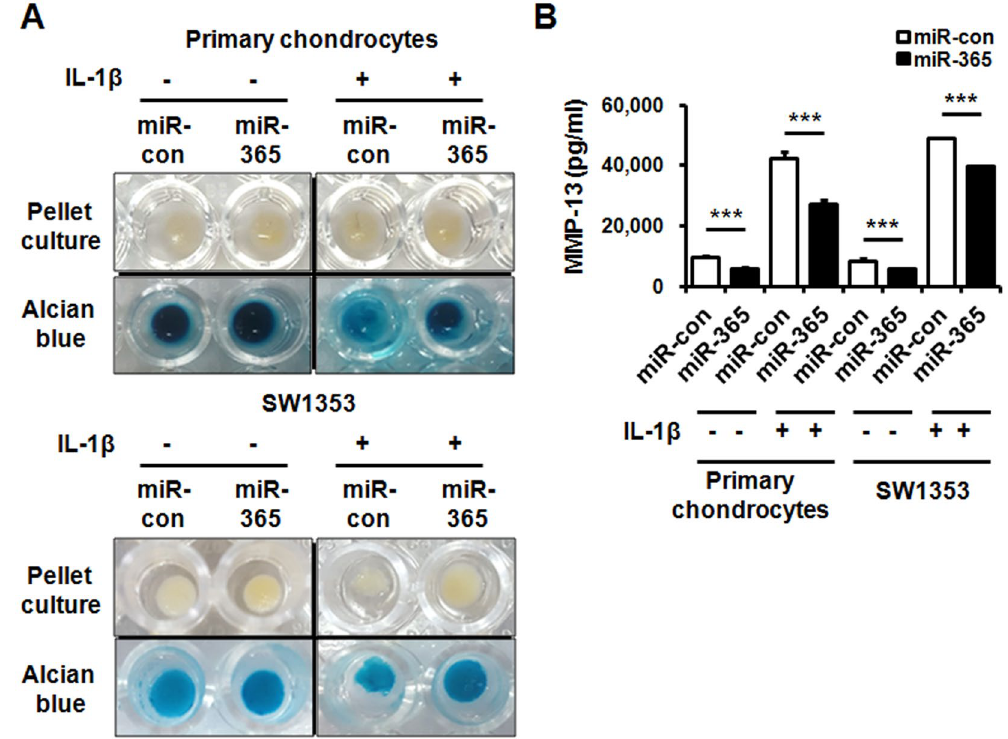
Figure 7. Suppression of loss of ECM and expression of MMP-13 by miR-365 in the pellet culture. ( A ) Alcian blue staining following 3D pellet culture of primary chondrocytes and SW1353 cells. Human primary chondrocytes and SW1353 cells were transfected with miR-con or miR-365 and the pellets formed by centrifugation were stimulated with IL-1 β (1 ng/mL) for 7 days. The medium containing IL-1 β was changed every second day for culture period. The pellets were stained with Alcian blue. ( B ) The levels of MMP-13 released into the medium from the pellet culture were measured by enzyme-linked immunosorbent assay (ELISA). Data are expressed as the mean ± SD of duplicate data from three independent experiments. ns, not significant, *** P < 0.005 vs. miR-con- or miR-con + IL-1 β -treated